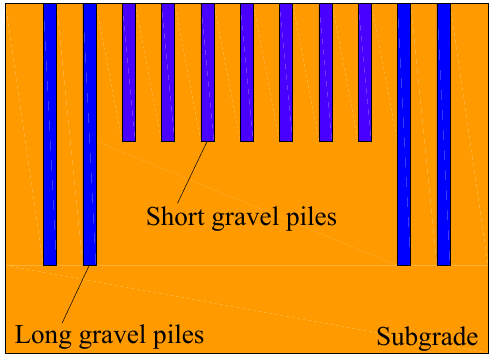
Figure 3. Subarea long-short gravel piles.